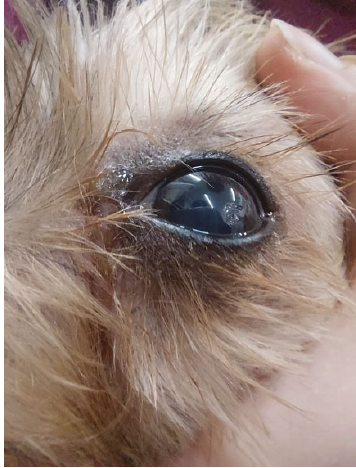
Figure 2. Corneal ulcer on the left eye of a